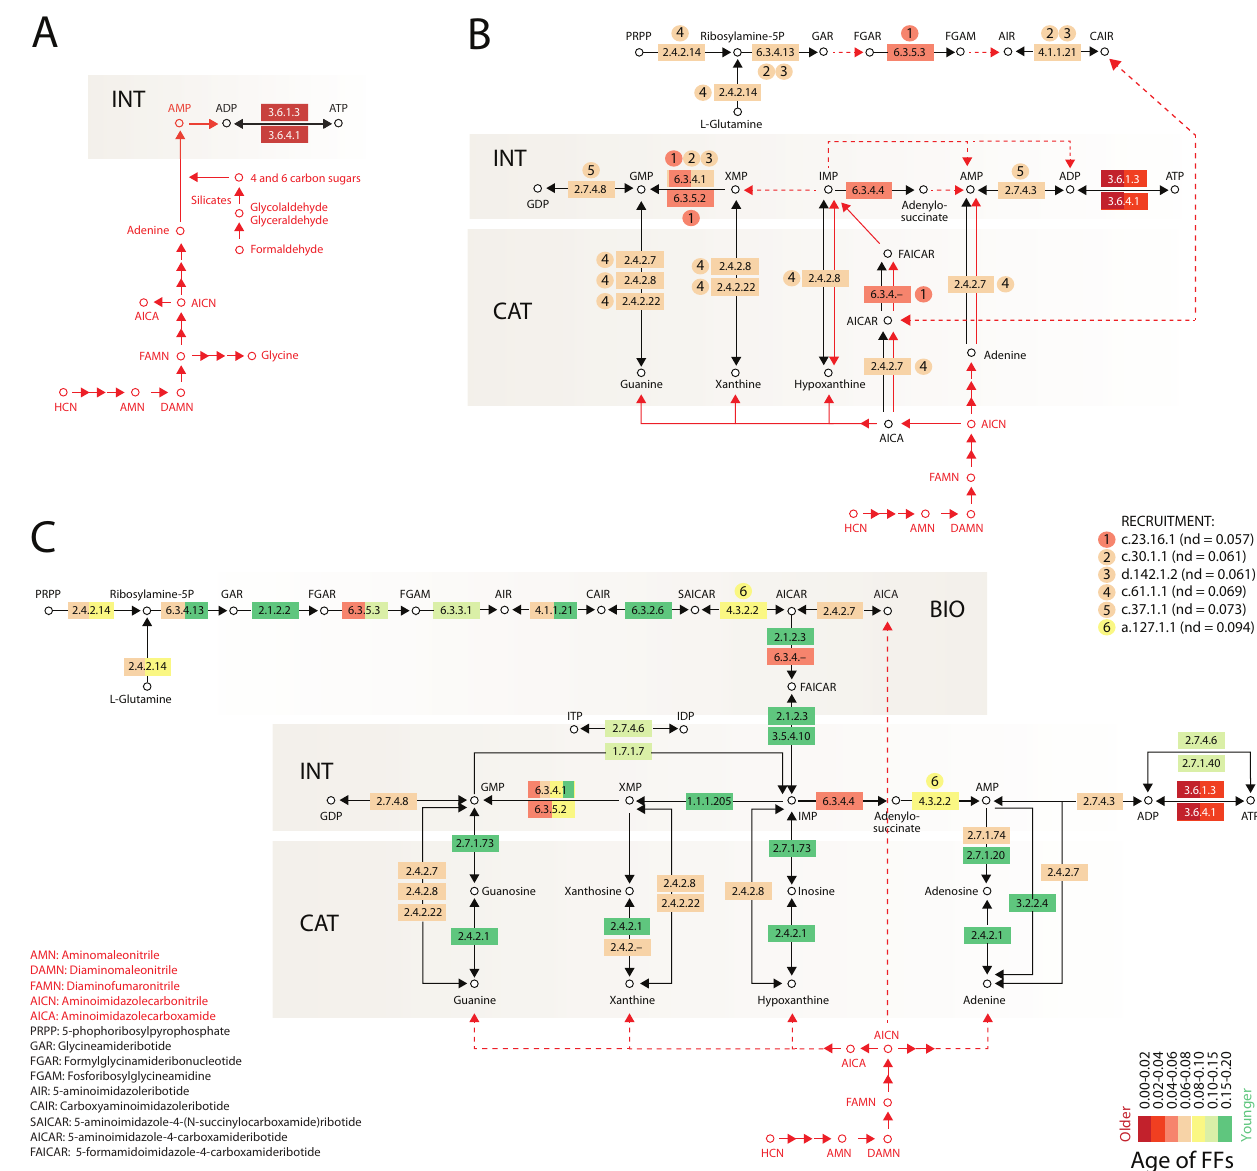
Figure 4. Early evolution of the purine metabolic network. A. Origin of nucleotide metabolism , 3.8 Gy ago; nd FF =0). B. Emergence of the nucleotide interconversion (INT), catabolism and salvage (CAT) and biosynthetic (BIO) pathways , 3.5 Gy ago ( nd FF =0.061–0.073). C. Fully connected INT, BIO and CAT pathways , 3 Gy ago ( nd FF =0.187). Pathways mediated by prebiotic chemistries that are plausible and most parsimonious are depicted in red and enable the growth of the emergent protein enzyme-mediated pathways of purine metabolism by structural and functional innovation and piecemeal recruitment (recruited FFs are indicated with numbers). Unknown candidate or withering prebiotic pathways are indicated with dashed lines. We note that primordial reactions of the BIO pathway (top of metabolic diagram) in B could have been non-operational in the absence of suitable prebiotic chemistries until later in evolution. FF structures associated with individual enzymatic activities (described in EC nomenclature) are painted according to their age, in a scale of node distance ( nd FF ) that ranges from 0 (the oldest enzymes; , 3.8 Gy ago) to 0.2 ( , 3.0 Gy ago).